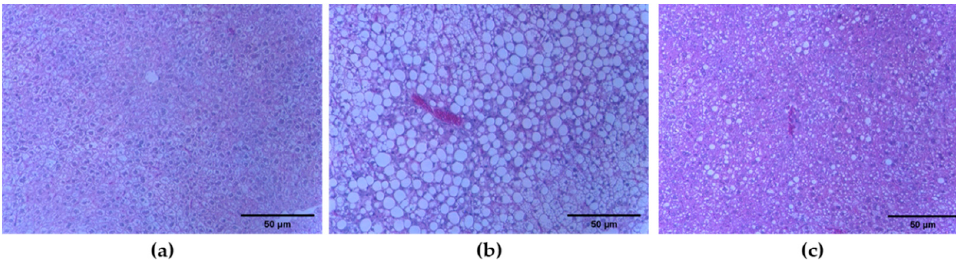
Figure 5. Effect of Jeju barley extract (BEE) on the histopathological change in liver tissues in the high fat diet-induced C57BL/6 mice. Liver tissues were stained with H&E (original magnification × 100). ( a ) Normal diet mice, ( b ) high fat diet mice, ( c ) high fat diet treated with BEE 0.3 g/kg-body weight.